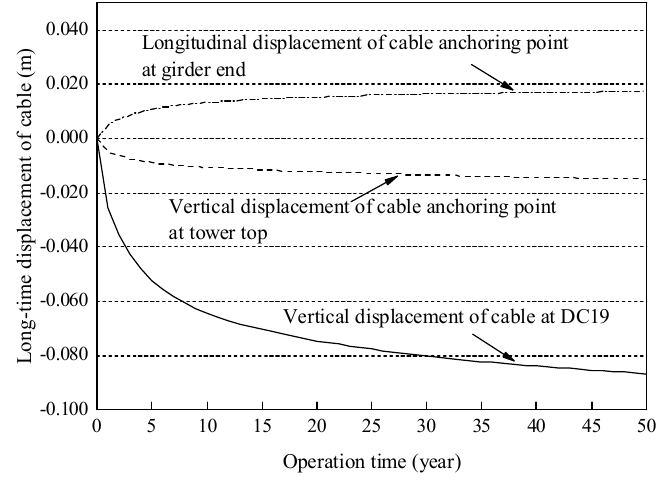
Figure 13. Predicted long-time displacements of cable.